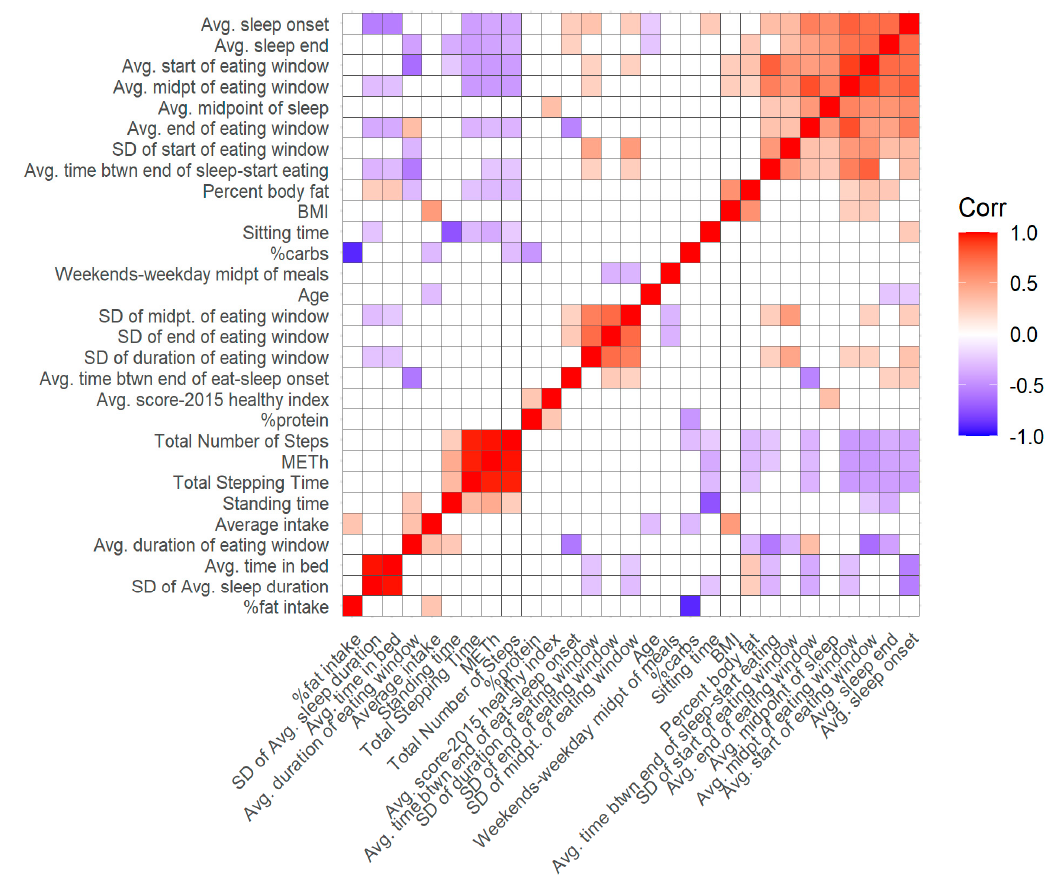
Figure 3. Heatmap showing correlations between body composition, energy intake, meal timing, physical activity and sleep variables. Darker shading indicates a greater degree of correlation, and correlations with p -values > 0.05 are displayed in white.